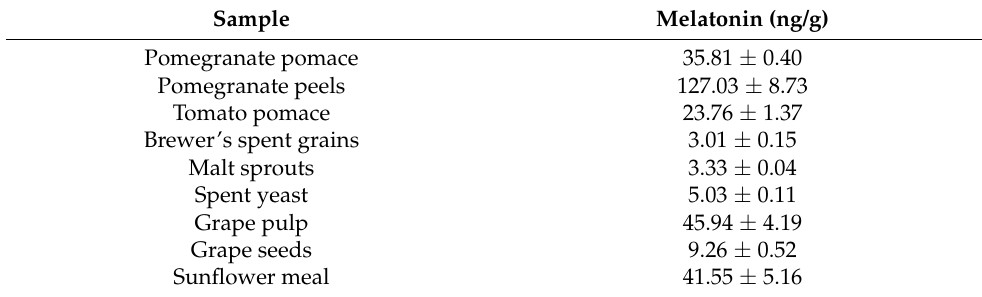
Table 1. Melatonin content in agri-food by-products analyzed by HPLC-ESI-MS.